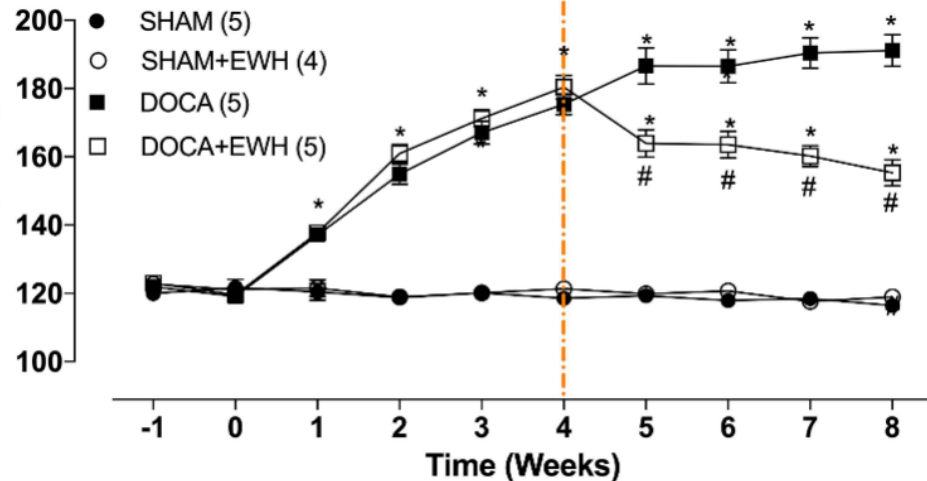
Figure 2. Effect of EWH on SBP in DOCA-salt hypertensive rats. SBP values of SHAM, SHAM+EWH, DOCA, and DOCA+EWH groups, measured before and after nephrectomy ( − 1 and 0 weeks), during DOCA-salt model induction (1 to 4th week), and during the maintenance of the DOCA-salt hypertensive model co-treated or not with EWH (5th to 8th week). The EWH treatment started on the 4th week after DOCA-salt or SHAM treatment (orange-marked line). Data are expressed as mean ± SEM. The number of rats is indicated in parentheses. Two-way ANOVA followed by Bonferroni post-test: p < 0.05 * vs. SHAM; # vs. DOCA.